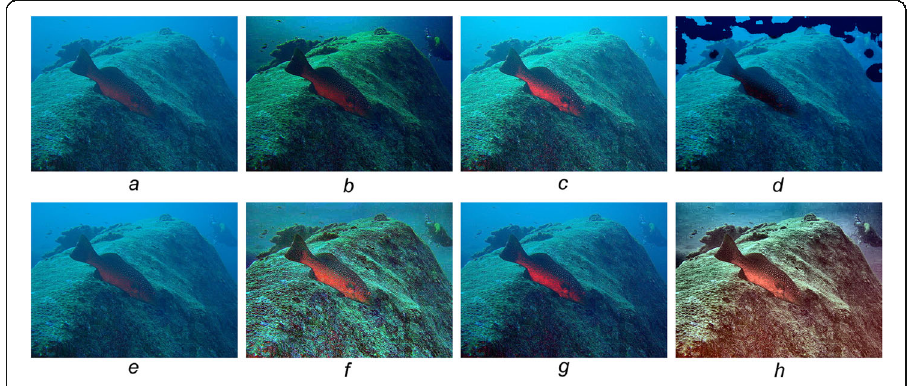
Fig. 10 Restoration results of the blue bulge image. a Input image. b With UDCP. c With ICM. d With FVR. e With DCP. f With ERD. g With IBLA. h With the proposed